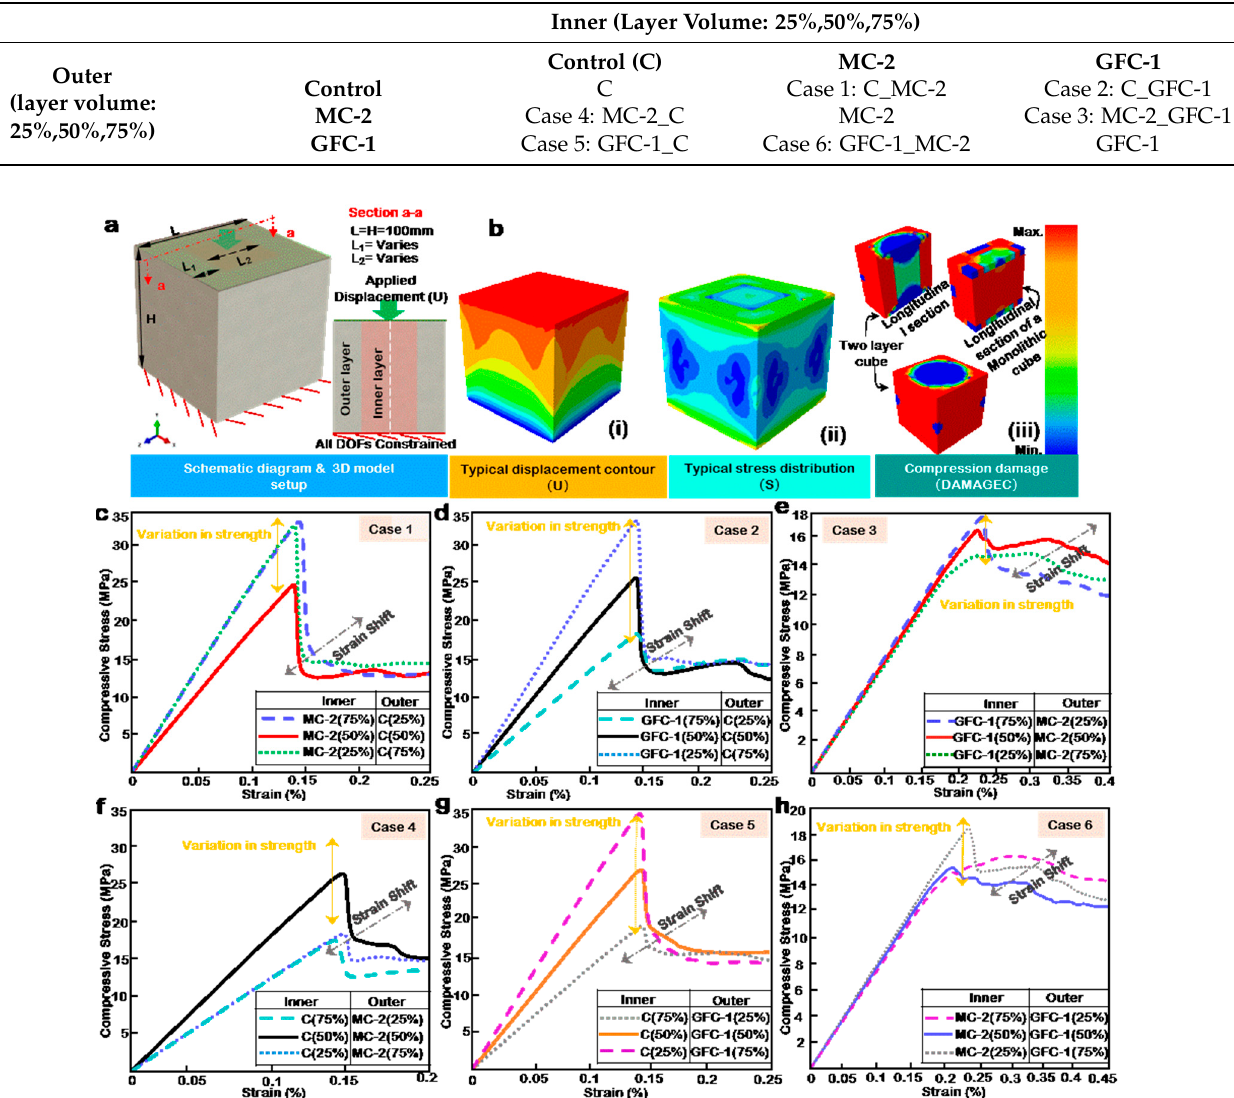
Figure 4. ( a ) Schematic diagram of the two-layer configuration, showing the applied displacement and boundary condition. ( b ) Two-layer configuration simulation contour plot of (i) Displacement, (ii) Misses stress, and (iii) Compression damage. Numerical stress–strain curve for ( c ) Case 1, ( d ) Case 2, ( e ) Case 3, ( f ) Case 4, ( g ) Case 5, and ( h ) Case 6.